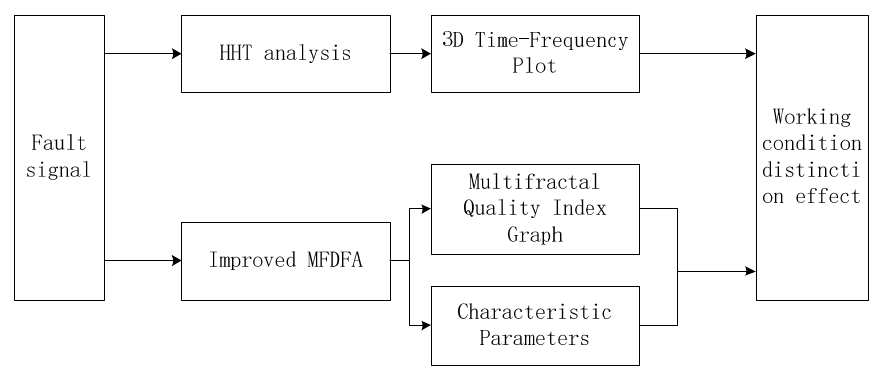
Figure 4. Analysis flow chart.